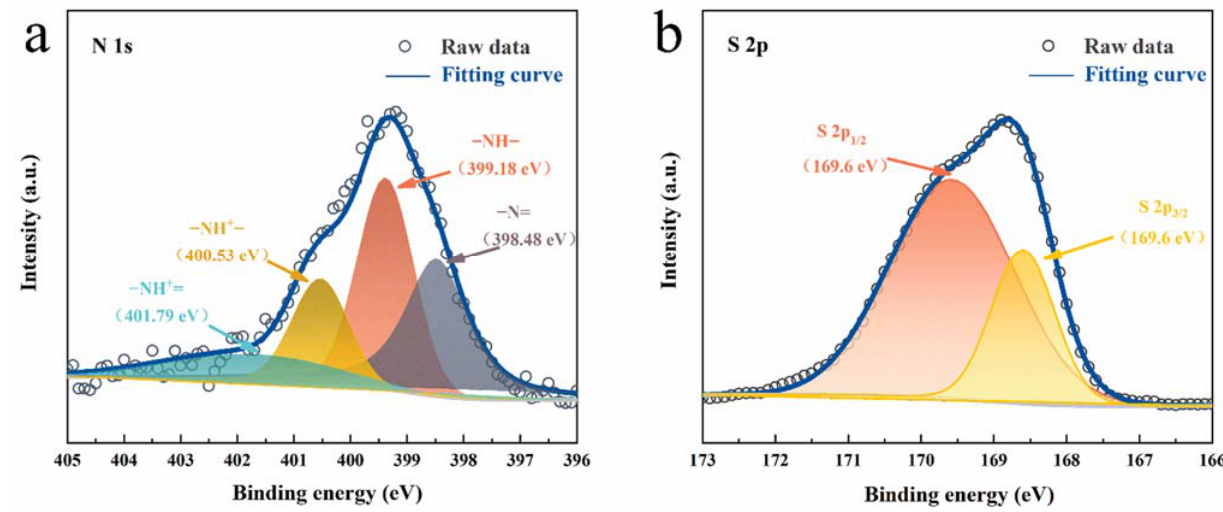
Figure 2. Core level XPS of ( a ) N 1s and ( b ) S 2p.